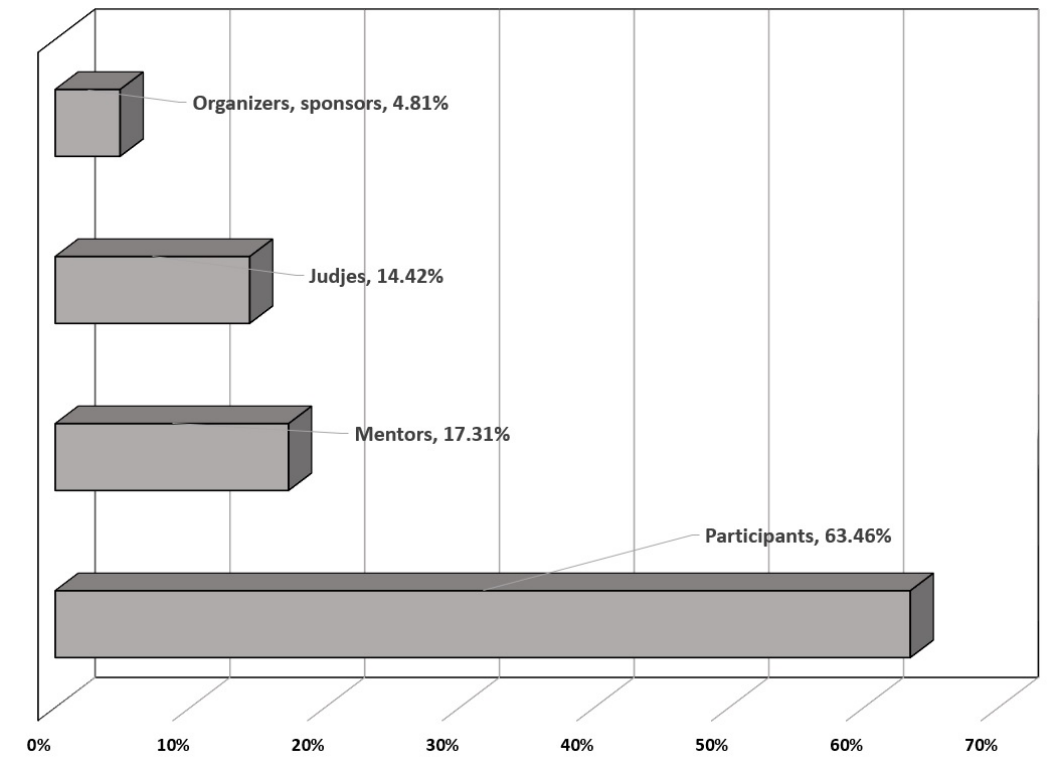
Figure 1: Participants of the